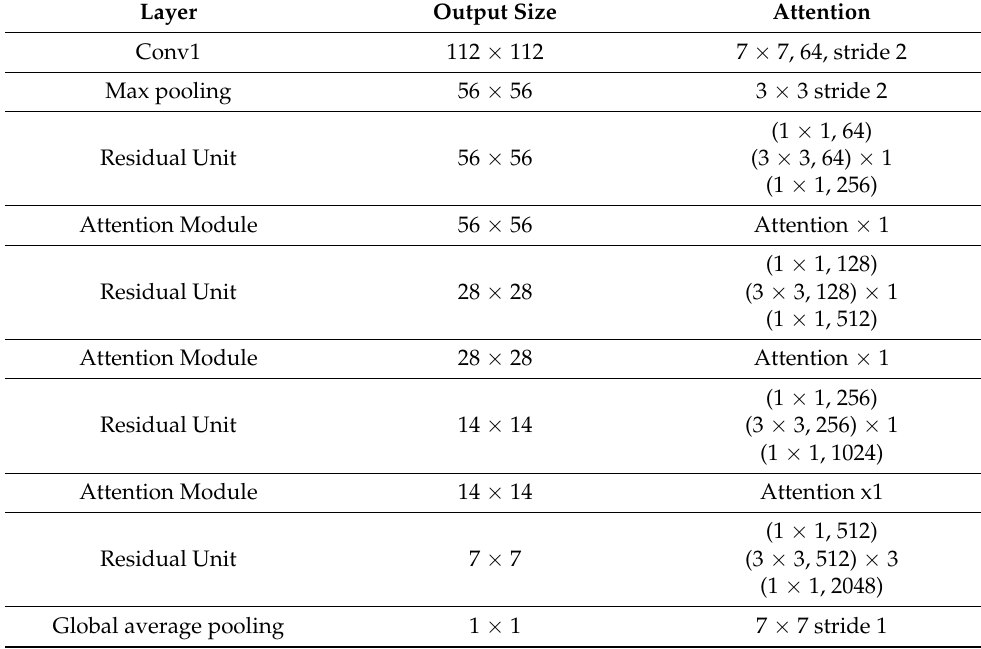
Table 2. Comparison of accuracy of different models.